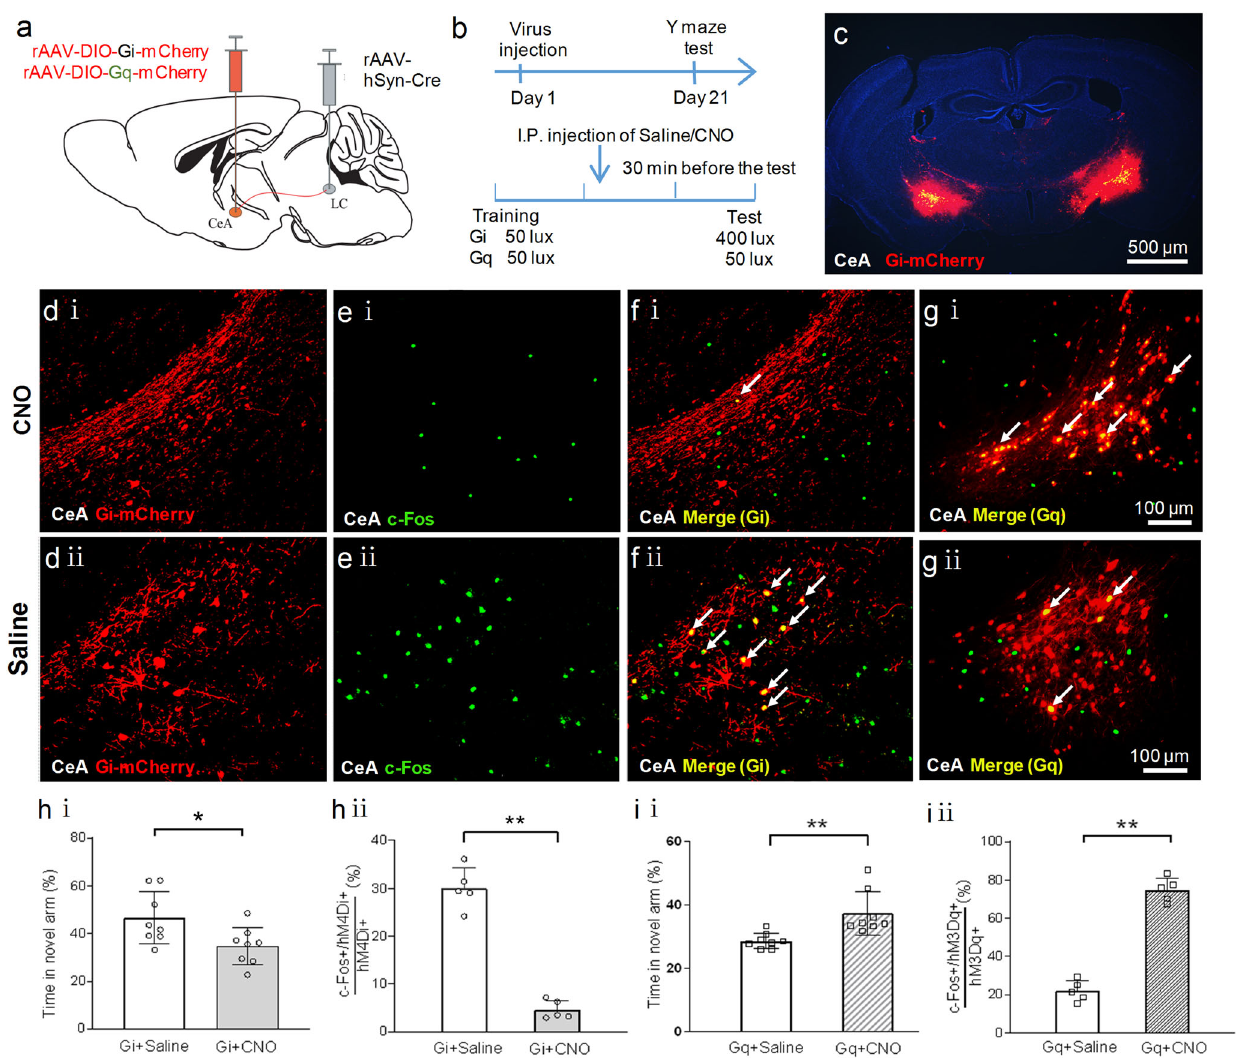
Fig. 4 Activation of the CeA-LC circuit plays a vital role in the enhanced spatial memory retrieval induced by 400 lux light exposure. a Schematic illustration of injecting different chemogenetic viruses into the CeA, and the injection of the rAAV-hSyn-Cre virus into the LC. b Experimental protocol and timeline. c The expression of mCherry in the CeA after injection of the rAAV-DIO-Gi-mCherry virus into bilateral CeA. d (i), d (ii) The expression of mCherry in the CeA neurons in both CNO and saline groups. e (i), e (ii) Representative images of immuno fl uorescence staining of c-Fos in CeA neurons after intraperitoneal injection of CNO or saline. f (i) The merged image of d (i) and e (i). f (ii) The merged image of d (ii) and e (ii). Cells co-labeled by mCherry and c-Fos were indicated by the white arrows. g (i), g (ii) Representative images of c-Fos staining and expression of mCherry in the CeA after intraperitoneal injection of CNO or saline in mice that received an intra-CeA injection of the rAAV-DIO-Gq-mCherry virus and intra-LC injection of the rAAV-hSyn-Cre virus. Cells double-labeled by mCherry and c-Fos were indicated by white arrows. h (i) In mice that express the inhibitory Gi-coupled receptors in the CeA, CNO induced chemogenetic inhibition of CeA neurons and decreased the time spent exploring the novel arm, as compared to saline. The light treatment during the test was 400lux. h (ii) CNO also reduced the number of c-Fos + neurons in the CeA. i (i) In contrast, in mice that express the excitatory Gq-coupled receptors in the CeA, CNO induced chemogenetic activation of CeA neurons and increased the time spent exploring the novel arm, as compared to saline (non-parametric Mann-Whitney U test). The light treatment during the test was 50 lux. i (ii) CNO also increased the number of c-Fos + neurons in the CeA. * P < 0.05, ** P < 0.01 vs. indicated group, two independent sample t-test unless otherwise noted, n = 7 – 8/group for behavioral test; n = 5/group for c-Fos